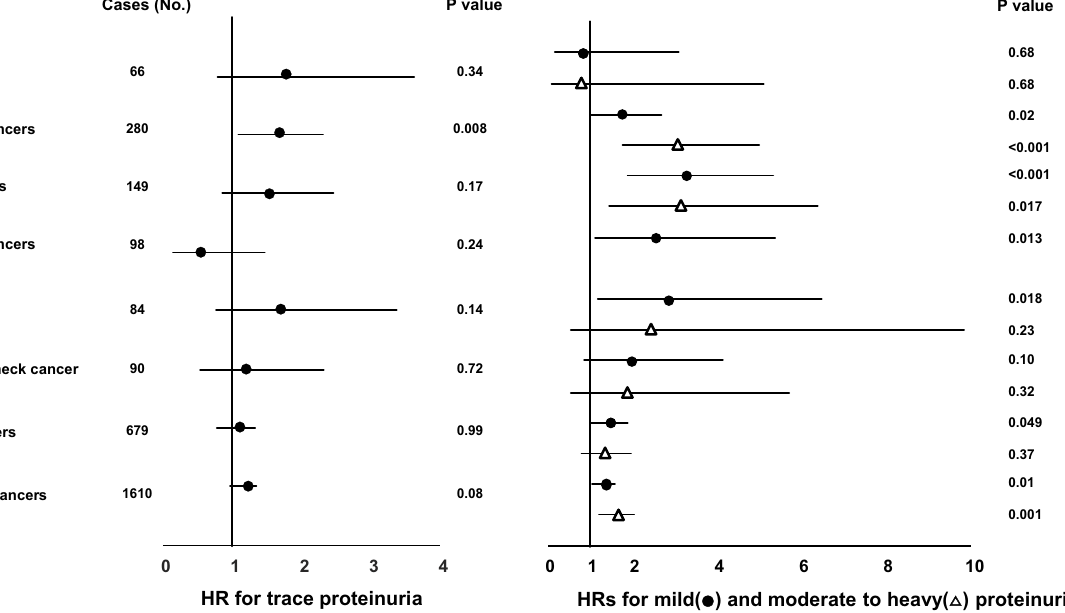
Figure 2. Multivariable-adjusted hazard ratio (95% confidence interval) of site-specific cancer death for trace, mild, and moderate to heavy versus negative proteinuria. * Data were not available due to the low number of gynecological cancer deaths in subjects with moderate to heavy